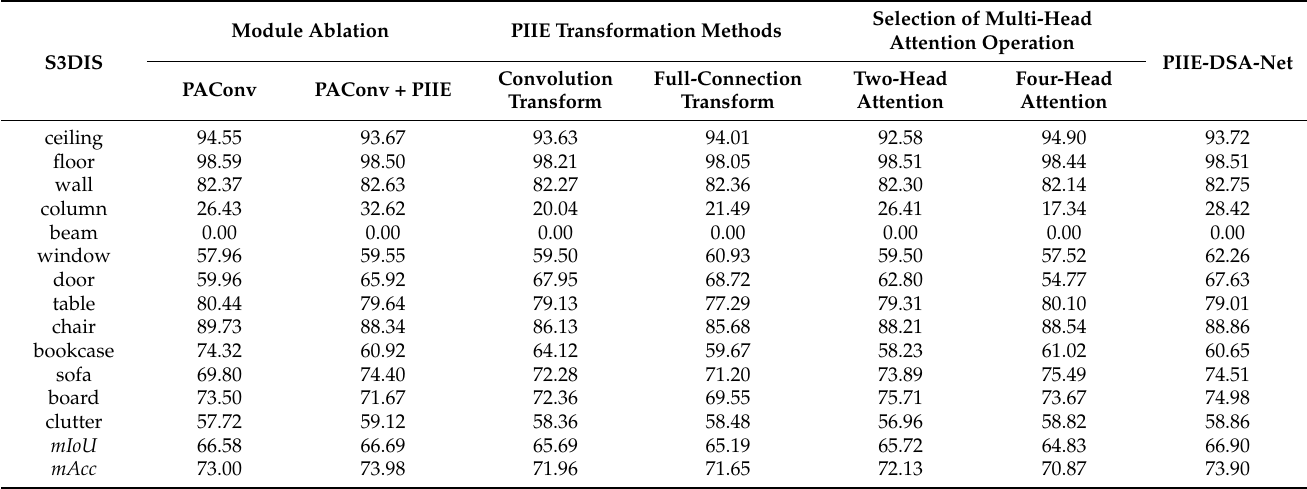
Table 5. Ablation experiments on the indoor dataset